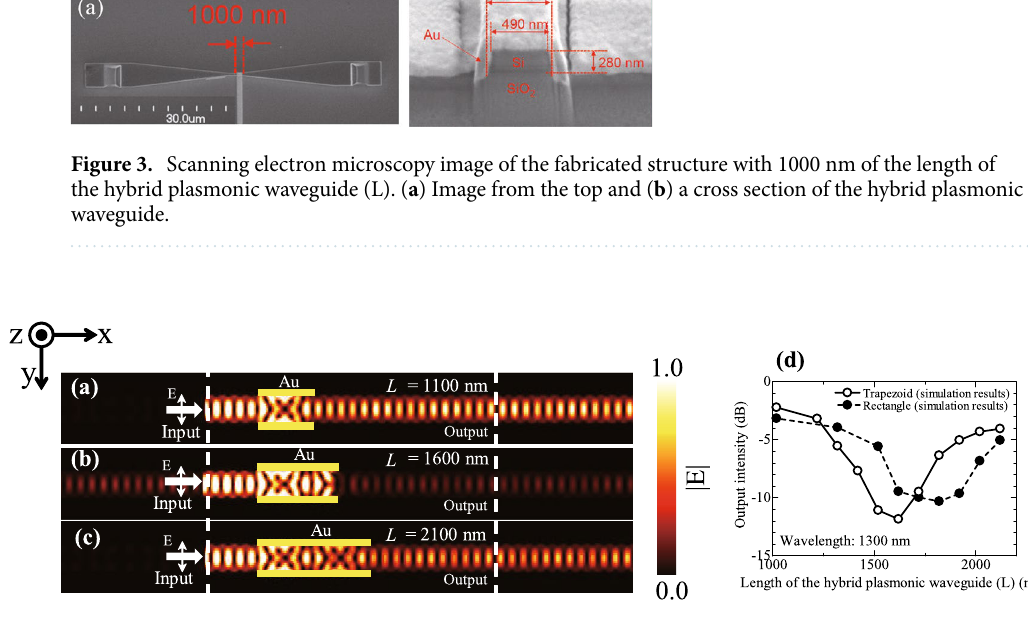
Figure 4. Profiles of electric field intensity at the centre of the hybrid plasmonic waveguide in the fabricated trapezoidal structure with ( a ) L = 1100 nm, ( b ) L = 1600 nm and ( c ) L = 2100 nm. The incident light wavelength is 1300 nm. The incident light has an electric field component in the y direction. ( d ) Output intensities as functions of L. Open circles show simulation results for the fabricated trapezoid structure. Closed circles show simulation results for the designed rectangular structure. The wavelength of incident light is 1300